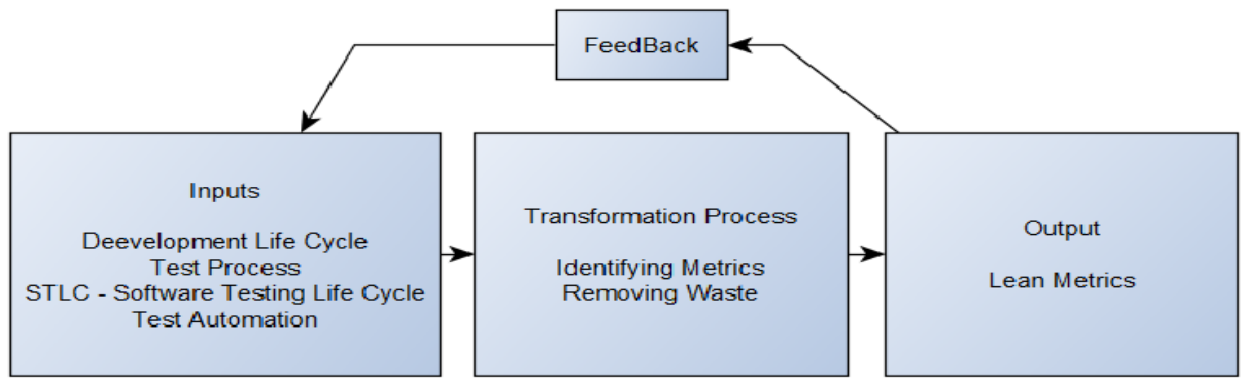
Fig. 7. Prototype for finding the right test metrics for lean canvas board using transformation